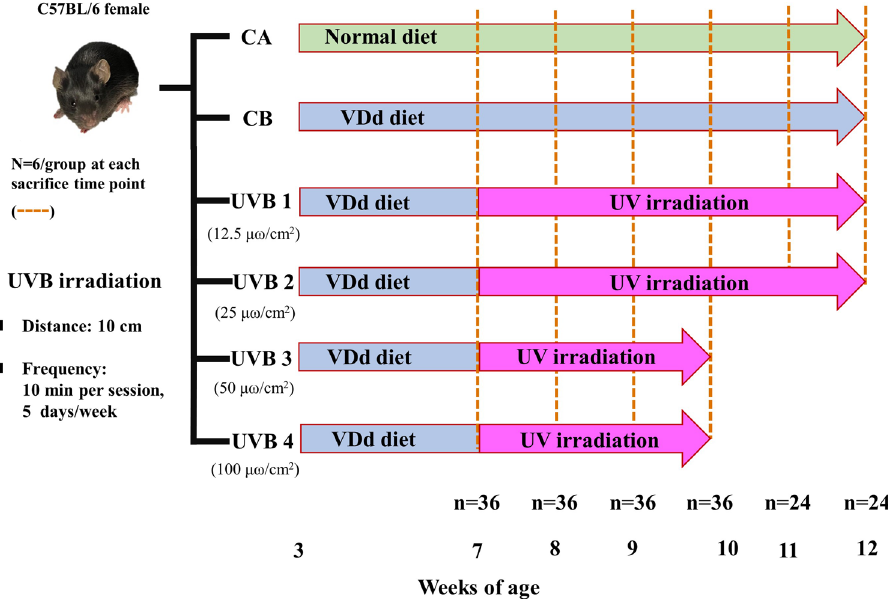
Figure 3. The experimental protocol. Inbred C57BL/6 female mice at three-weeks-old were randomly divided into the following six groups: (1) Control A (CA), fed a normal diet during the entire experiment; (2) Control B (CB), fed a vitamin-D deficient (VDd) diet during the entire experiment; (3) UVB 1, fed a VDd diet during the entire experiment and exposed to 12.5 μω/cm 2 UVB after being fed the VDd diet for 4 weeks; (4) UVB 2, fed a VDd diet during the entire experiment and exposed to 25 μω/cm 2 UVB after being fed the VDd diet for 4 weeks; (5) UVB 3, fed the VDd diet during the entire experiment and exposed to 50 μω/cm 2 UVB after being fed the VDd diet for 4 weeks; and (6) UVB 4, fed the VDd diet during the entire experiment and exposed to 100 μω/ cm 2 UVB after being fed the VDd diet for 4 weeks. For all six groups, the same sacrifice time points were at 7, 8, 9, and 10 weeks-of-age; and for the groups of CA, CB, UVB 1 and UVB 2, there were two additional points at 11 and 12 weeks-of-age. The frequency of UVB irradiation was 10 min /day and 5